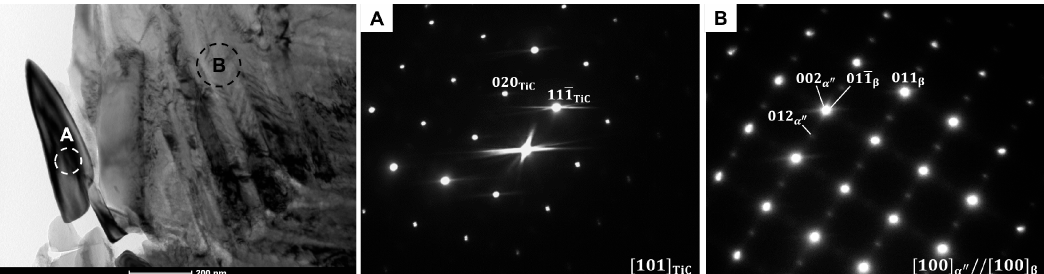
Figure 4. BF/TEM micrograph of Ti-8Nb-2Mo alloy presenting the elongated precipitation occurred inside the β -phase grain with the corresponding SADPs (A and B correspond to the areas marked by the circles).